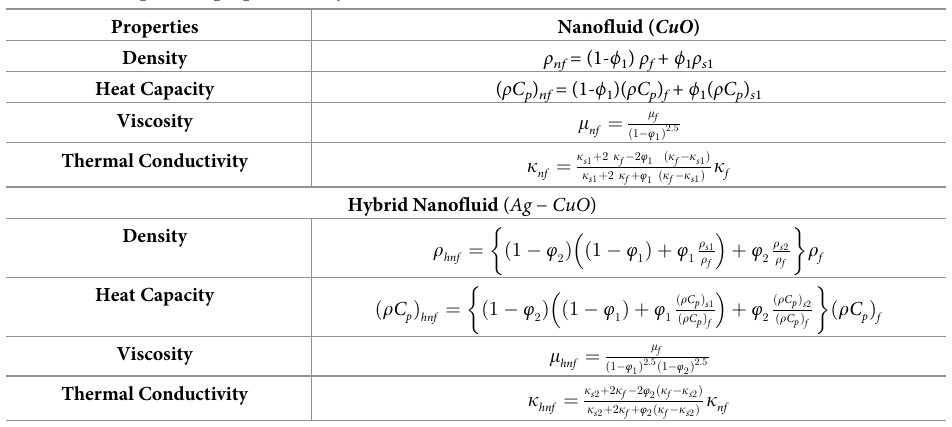
Table 2. Themophoresis properties of hybrid nanofluid [3,